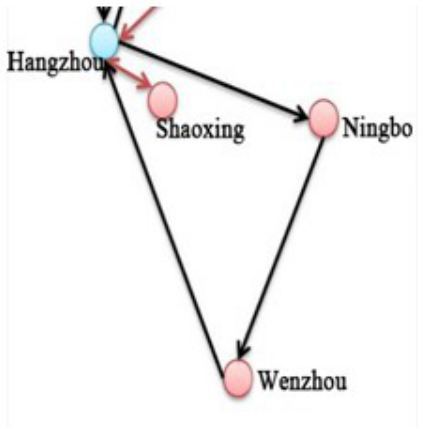
Figure 3(2). The final optimization